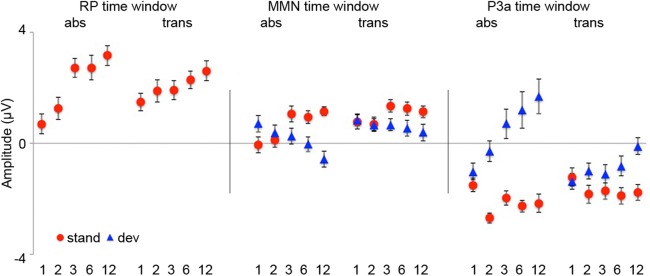
Mean amplitudes for standards and deviants in RP, MMN and P3a time windows.Mean amplitudes (N = 18) in 100 ms time windows for RP (50 to 150 ms), MMN (166 to 266 ms) and P3a peak in the absolute (abs: 334 to 434 ms) and in the transposed (trans: 450 to 550 ms) repetition condition elicited to standard (red circles) and deviant (blue triangles) stimuli separately for trains of 1, 2, 3, 6, and 12 sound pattern presentations. Whiskers denote standard errors.